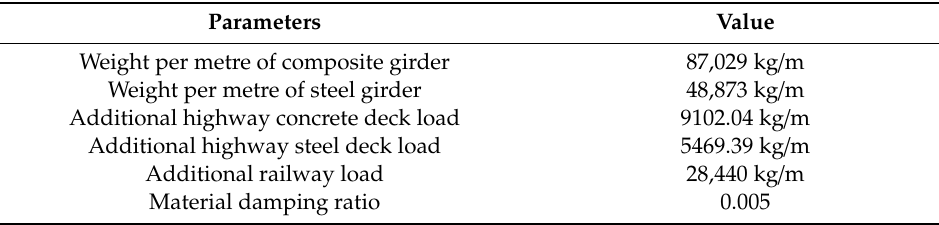
Figure 14. Segment model of different girder types. Table 5. Static and dynamic parameters of the equivalent fish-bone model of the girder.